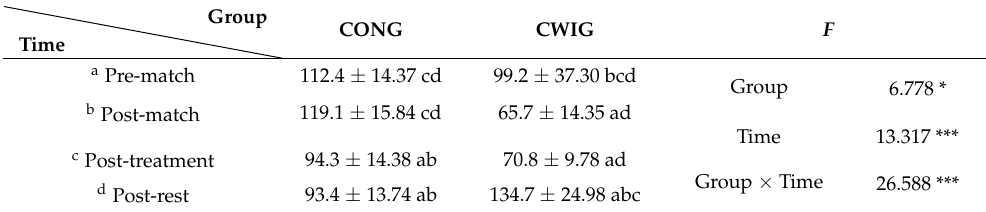
Table 4. Change in glutathione peroxidase (GPX) concentration after CWI (unit/µ mol). Group CONG Time